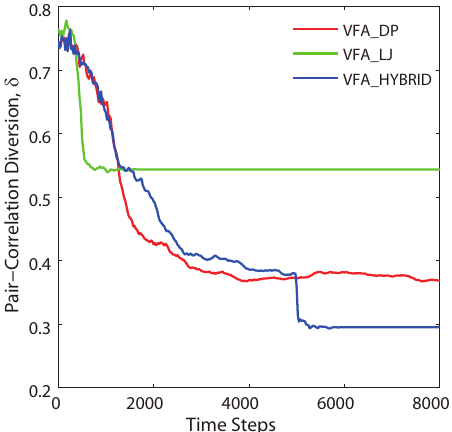
Figure 4. Performance evaluation profiles of the PCD δ ( Ω , Ω H ) as a function of the time step from VFA-LJ, VFA-DP and VFA-Hybrid algorithms,